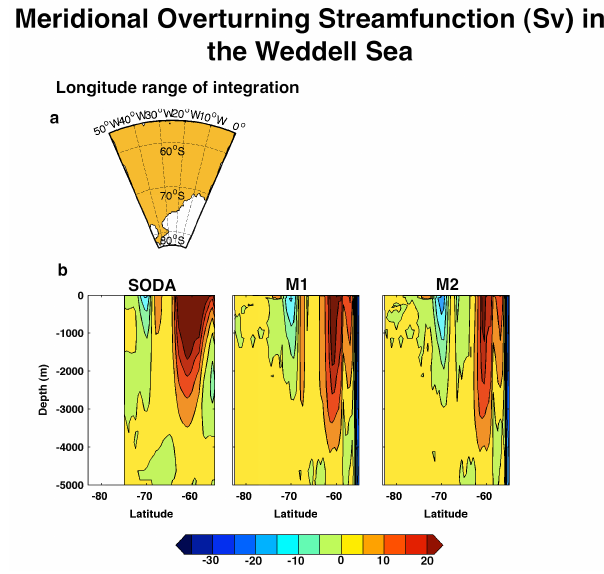
Fig. 8. Weddell Sea (a) annual mean meridional overturning circulation in Sverdrups for SODA, M1 and M2 simulation results